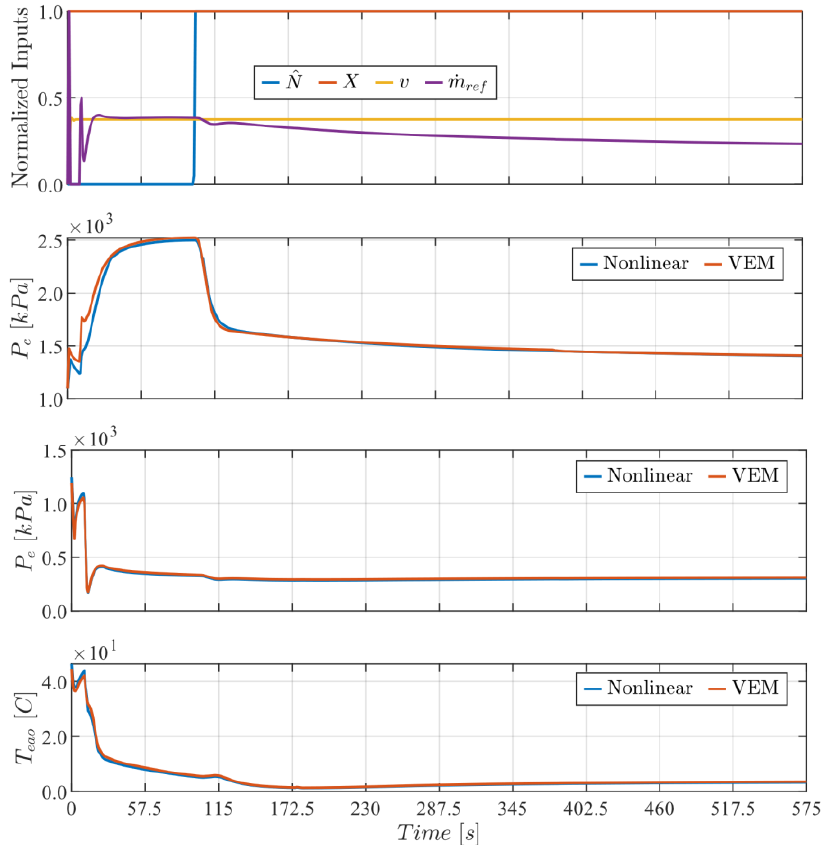
Figure 6. VEM and NL model comparison for fan speed step input — 0 rpm to 2500 rpm.